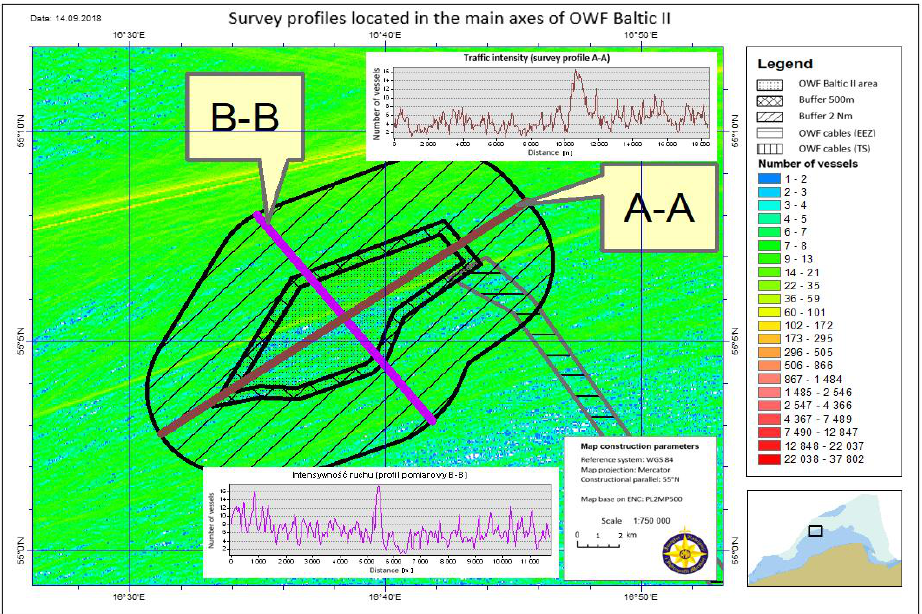
Figure 9. Traffic intensity of all types of ships on the main axes of the OWF area increased by a 2 Nm buffer (the pr ofiles formed a 2” GRID mesh).